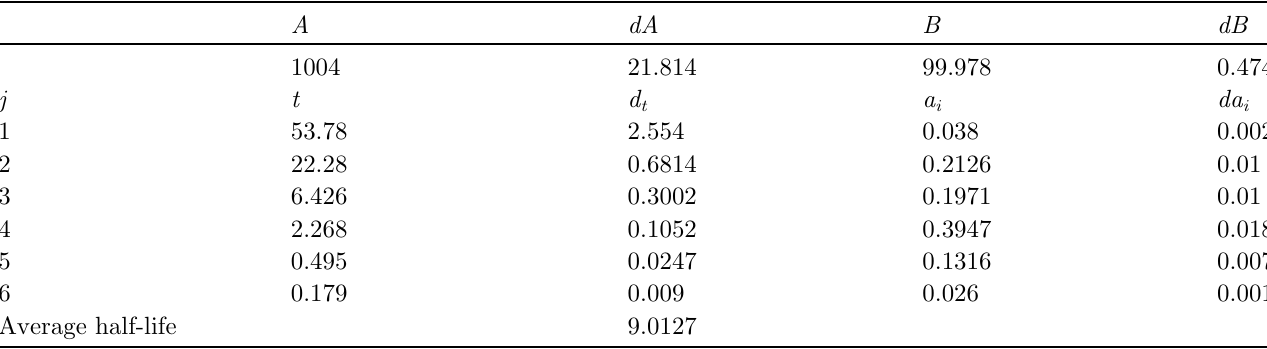
Table C2. Correlation matrix appropriate to the input dataset ( a